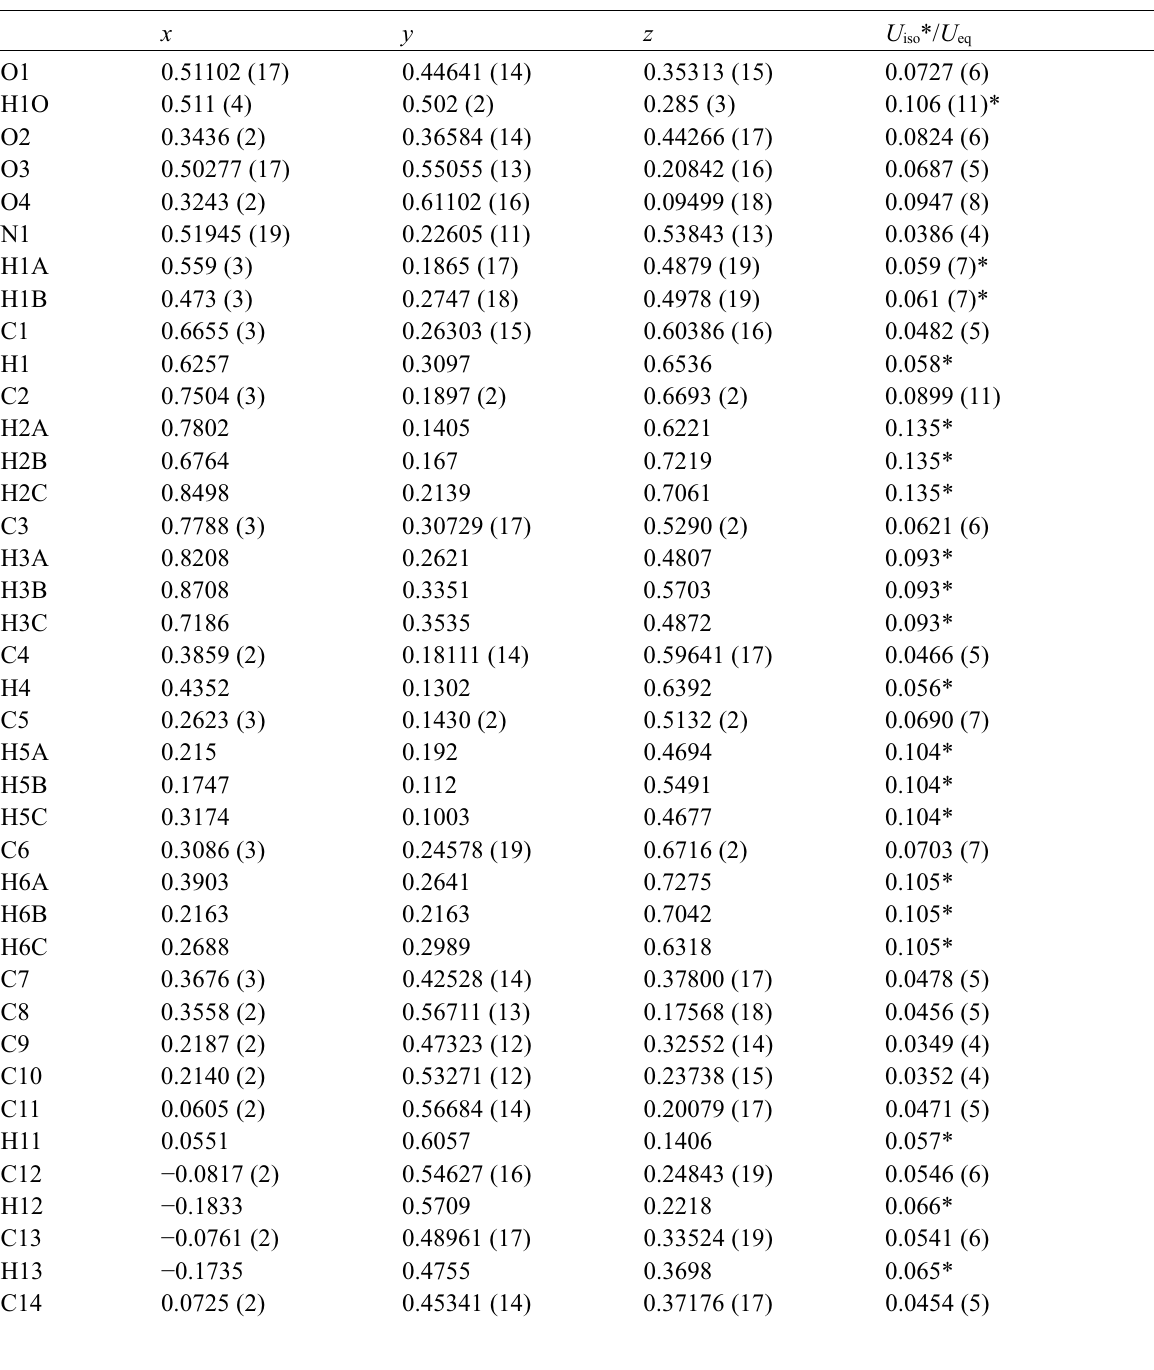
C—H hydrogen atom isotropic displacement parameters were set using the and hydrogen-atom isotropic displacement parameters were set using the approximation U atoms were refined freely, including isotropic displacement